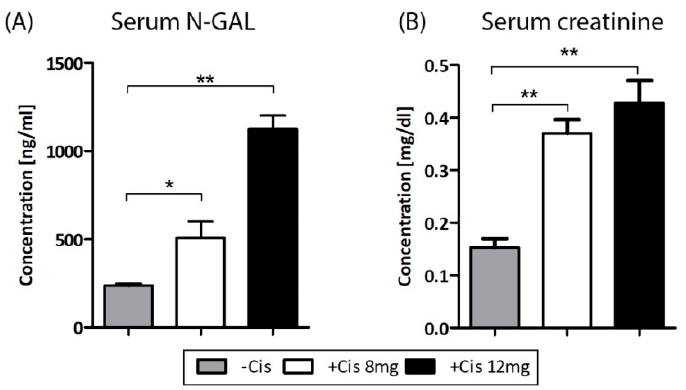
Figure 3. Effect of cisplatin injection on serum N-GAL ( A ) and creatinine ( B ) levels. Mice were injected with 8 mg/kg and 12 mg/kg cisplatin i .p . and serum levels of N-GAL and creatinine were measured on day 6. Data are expressed as ng/mL (N-GAL) and mg/mL (creatinine) (mean ± SEM); * p < 0.05 and ** p < 0.01 vs. control; n = 5 per group.